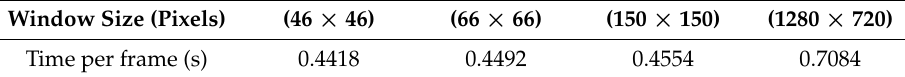
Table 7. Comparison of the processing speed for CRCHT and Indexing method. Table 8. Window sizes versus the processing speed of the images.